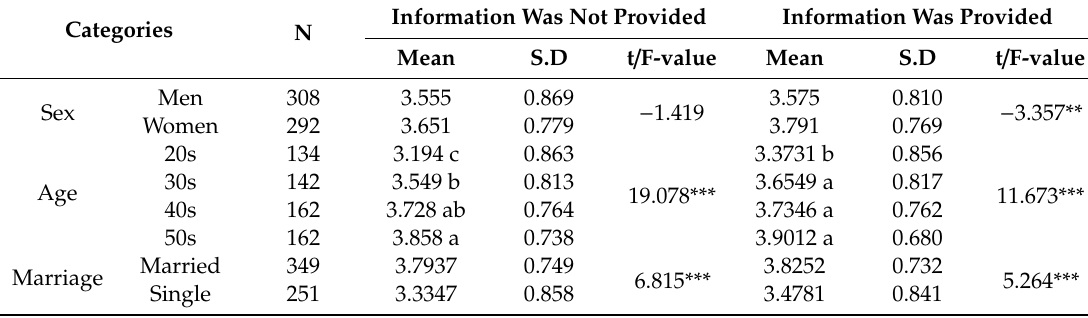
Table 2. Di ff erences in risk perception according to demographic characteristics.